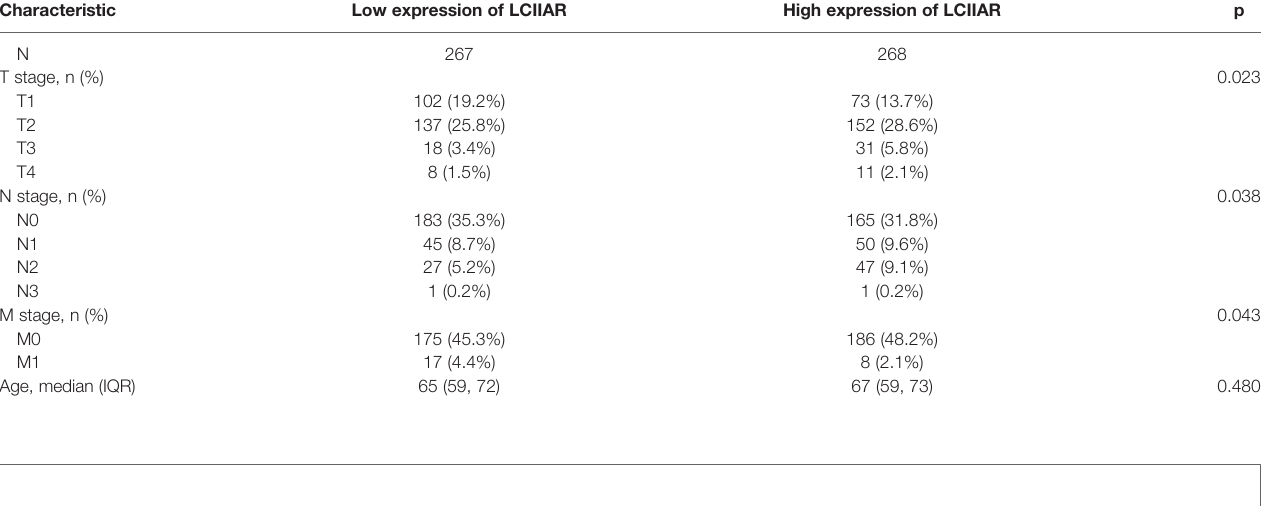
TABLE 1 | Correlation between LCIIAR expression and clinical characteristic. Characteristic Low expression of LCIIAR